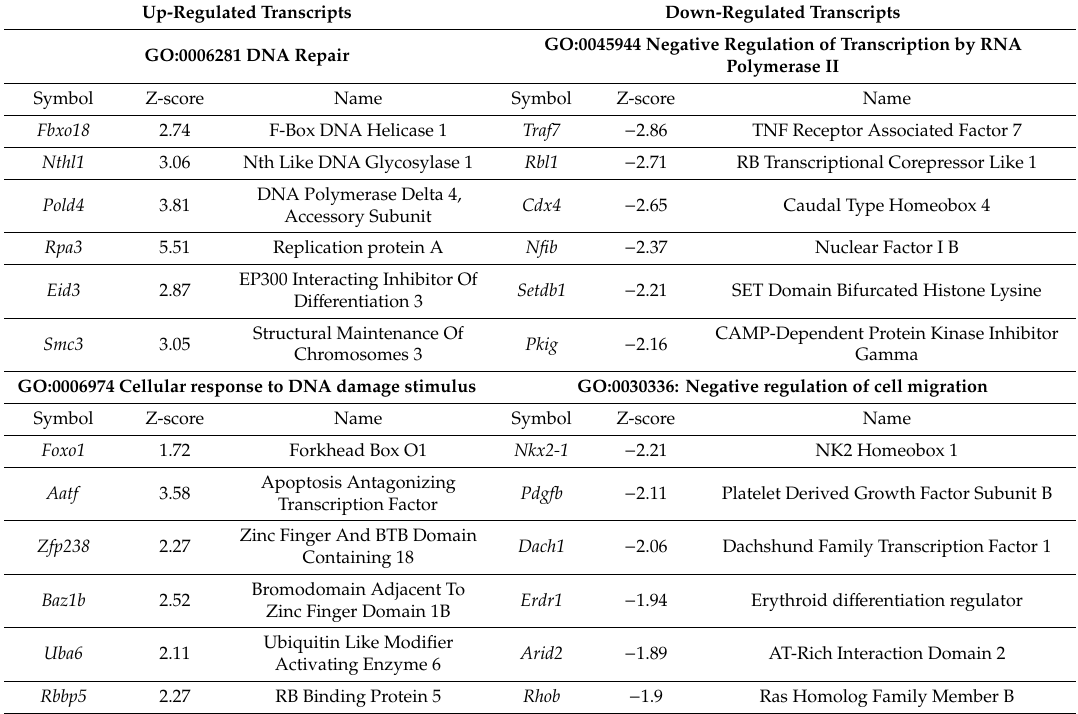
Table 1. Gene ontology analysis with the GeneCodis4 tool of signaling pathways and main transcripts modified by purinergic stimulation in CCl 4 -treated